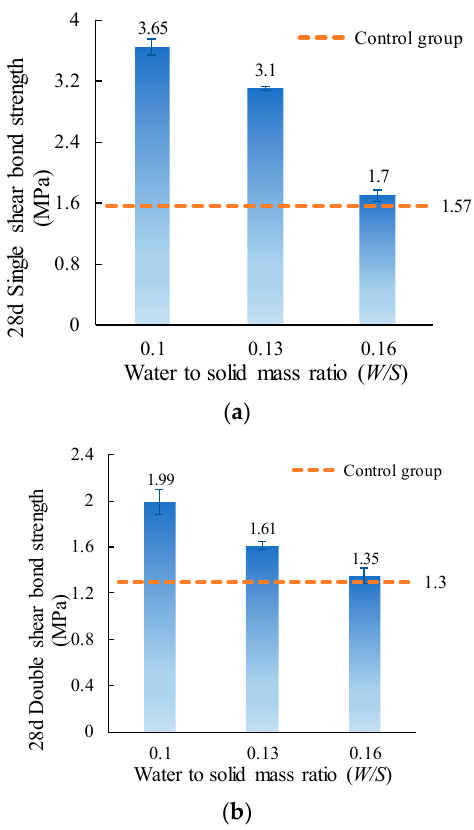
Figure 5. ( a ) Single shear bond strength and ( b ) double shear bond strength of specimens with var- ying W / S .